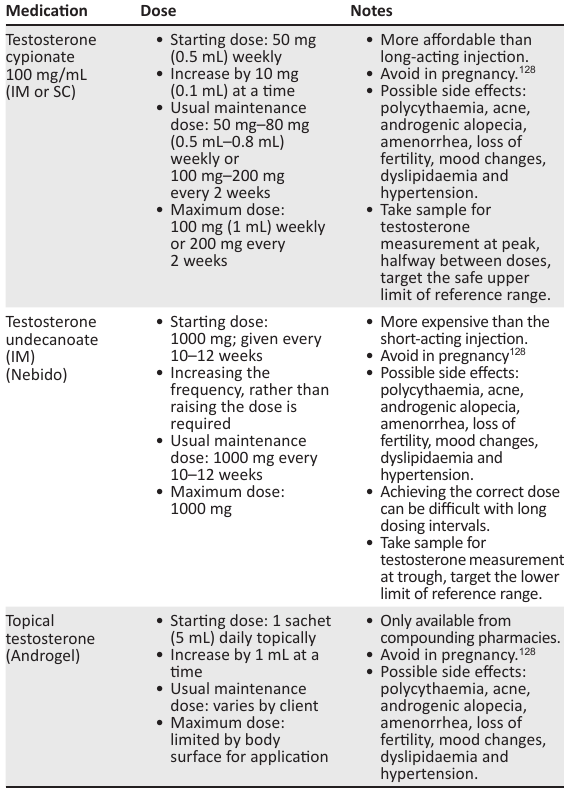
TABLE 7: Masculinising hormone therapy.